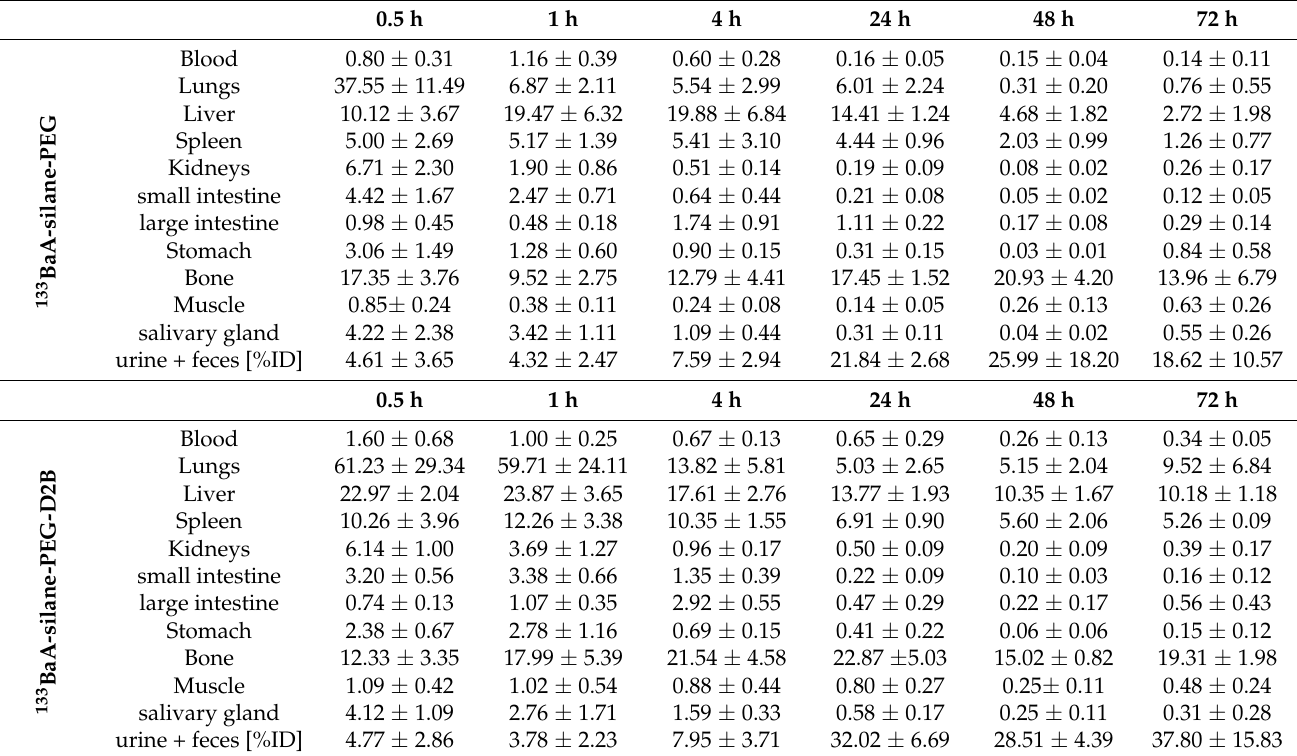
Table A1. Biodistribution of 133 BaA-silane-PEG and 133 BaA-silane-PEG-D2B in BALB/c mice at 0.5, 1, 4 24, 48 and 72 h post injection. Values are expressed as %ID g − 1 and presented as mean ± standard